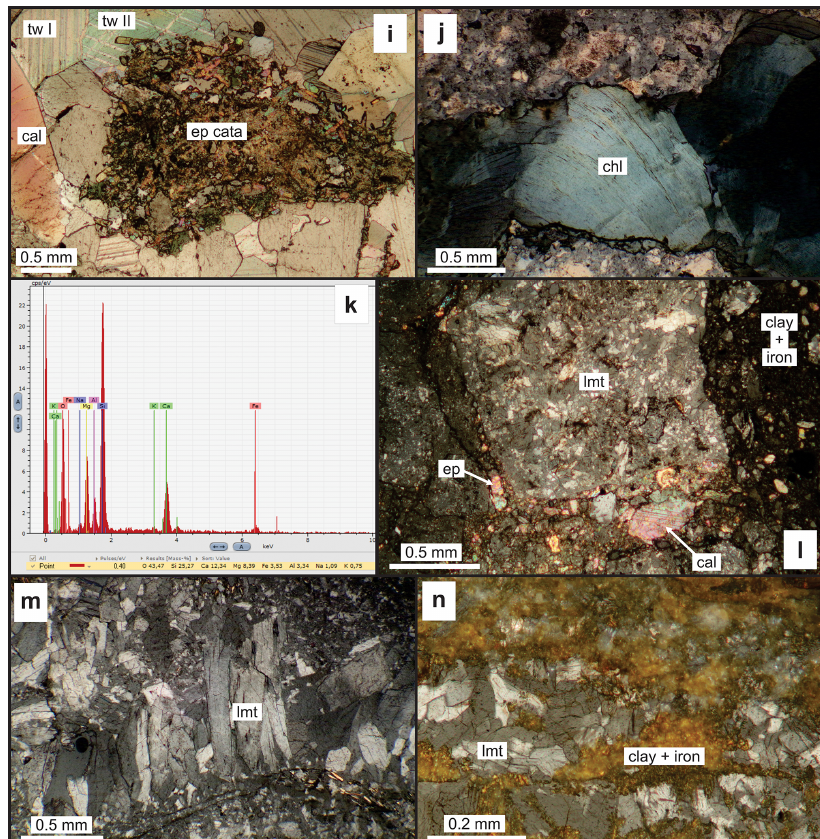
Figure 3. Microscope photographs of cataclasite and host rock in NW Finnmark. (a) Precambrian S-C foliation made of muscovite (ms) microcrystals surrounding K-feldspar (Kfs) sigma clasts. Location at faults 3 and 4 (Fig. 1); (b) cataclasite vein (dashed green) in Precambrian basement rocks seemingly offset by iron- and clay-rich fractures that formed parallel to existing S-C foliation deformation planes (dotted pink). The amount of offset across iron-rich fractures is shown by a dextrally (red) offset, sheared quartz grain (yellow) and is lower than the apparent offset of the cataclastic vein in green. Location at faults 3 and 4 (Fig. A1); (c) calcite-filled (cal) fracture in Precambrian basement rocks cross-cutting a vein of recrystallized quartz (qz) and a muscovite-bearing (ms) ductile microshear. Calcite cement crystals typically show type II (tw II; lower right inset) and type IV (tw IV; upper left inset) twinnings. Location at faults 3 and 4 (Fig. A1); (d) preserved biotite (bt) foliation in Caledonian host rocks near a cataclastic (cata) brittle fault. Approaching the fault, biotite is increasingly recrystallized into chlorite (chl). Location at fault 7 (Fig. A1); (e) highly fractured garnet crystal (grt) in Caledonian host rock cross-cut by epidote- (ep; type 1) and quartz-rich cataclasites (qz cata; type 2), which are both truncated by calcite-filled veins (cal; type 3). Both cataclasites and calcite veins are truncated by a third cataclasite made up with a matrix of angular, poorly sorted clasts of laumontite (lmt; type 4) cross-cut by late clay- and iron-bearing veins (type 5). Location at the Langfjorden fault segment of the LVF (Koehl et al., 2018b), approximately 10–15km west of the Talvik fault (fault 5 in Fig. A1); (f) Caledonian S-C foliation made of muscovite (ms) microcrystals surrounding K-feldspar (Kfs) sigma clasts that have partly recrystallized into quartz (qz). Location at faults 1 and 2 (Fig. A1); (g) cataclastic fault rock showing the remains of preexisting S, C and C (cid:48) foliation deformation planes in dotted yellow along which brittle fractures formed. Location approximately 10–15km south–southeast of fault 7 (Fig. A1); (h) epidote-rich cataclasite (ep cata; type 1) in Caledonian host rock including clasts of stilpnomelane (stp) cross-cutting quartz-rich host rock (qz) and truncated by quartz-rich cataclasite (qz cata; type 2), which incorporates clasts of epidote- rich cataclasite (yellow; type 1). Epidote- (type 1) and quartz-rich (type 2) cataclasites are truncated by subsequent clay- and iron-rich veins (type 5). Location at fault 9 (Fig. A1); (i) epidote-rich cataclasite (ep cata; type 1) embedded within a calcitic cement (cal; type 3) made of large crystals showing type I (tw I) and type II (tw II) twinnings. Location at the Straumfjordbotn fault (Koehl et al., 2018b, their Fig. 6g), a few kilometers east of faults 1 and 2 (Fig. A1); (j) fracture with chlorite (chl) precipitation related with type 1 cataclasite. Location at fault 7 (Fig. A1); (k) SEM analysis of the atomic composition of the stilpnomelane crystal shown in type 1 cataclasite in panel (h) . The numbers below the graph represent mass percentage of each atom; (l) large clasts of laumontite-rich (lmt; type 4) cataclasite cross-cut at the bottom of the photograph by a cataclastic vein including clasts of epidote (ep; type 1), quartz (type 2), calcite (cal; type 3) and laumontite (type 4), and on the right hand-side by a cataclastic vein containing mostly iron-bearing and clay minerals (type 5). The iron- and clay-rich cataclasite (type 5) truncates all the other types of cataclasites. Location as panel (e) ; (m) laumontite precipitation (lmt; type 4 cataclasite). Crystals are elongated perpendicular to the fracture along which they precipitated. Location 4–5km west–northwest of fault 9 (Fig. A1; also see Koehl et al., 2018b, their Fig. 12c); (n) iron- and clay-rich (type 5) cataclasite cross-cutting mildly fractured late growth of laumontite (lmt; type 4). Location at the Øksfjorden fault, in Øksfjorden (Koehl et al., 2018b, their Fig. 7b), approximately 25km west–northwest of fault 5 (Fig. A1). Solid Earth, 9, 923–951, 2018